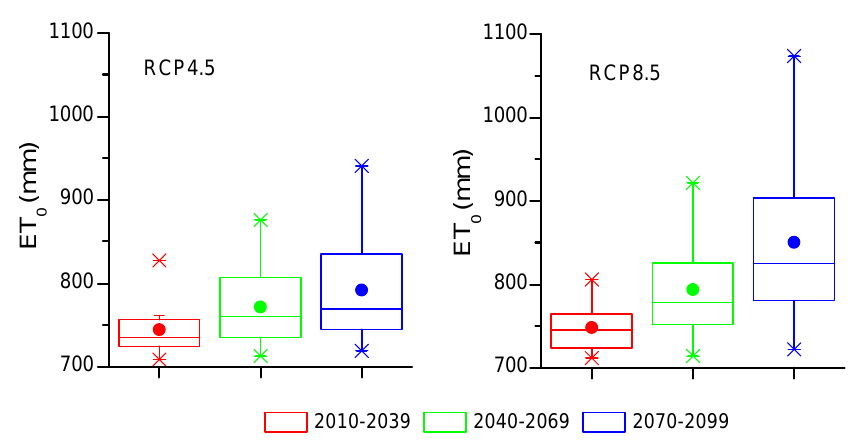
Figure 8. Boxplots for the future annual ET 0 projection under the RCP4.5 and RCP8.5 scenarios.